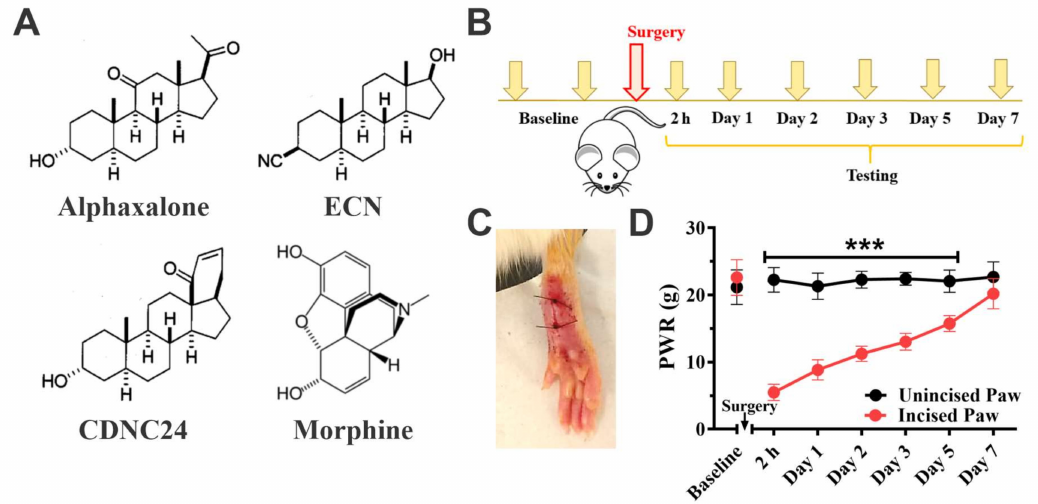
Figure 1. The development of postsurgical mechanical hypersensitivity in rats. ( A ). Chemical structures of compounds investigated in the present study: Alphaxalone, ECN, CDNC24 and